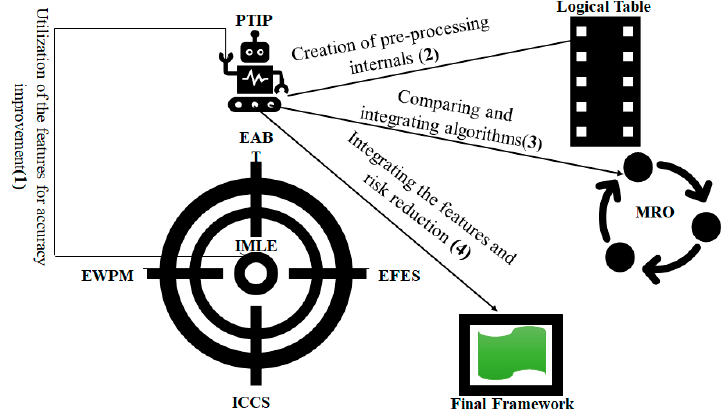
Figure 1. Functional components of PTIP for accuracy